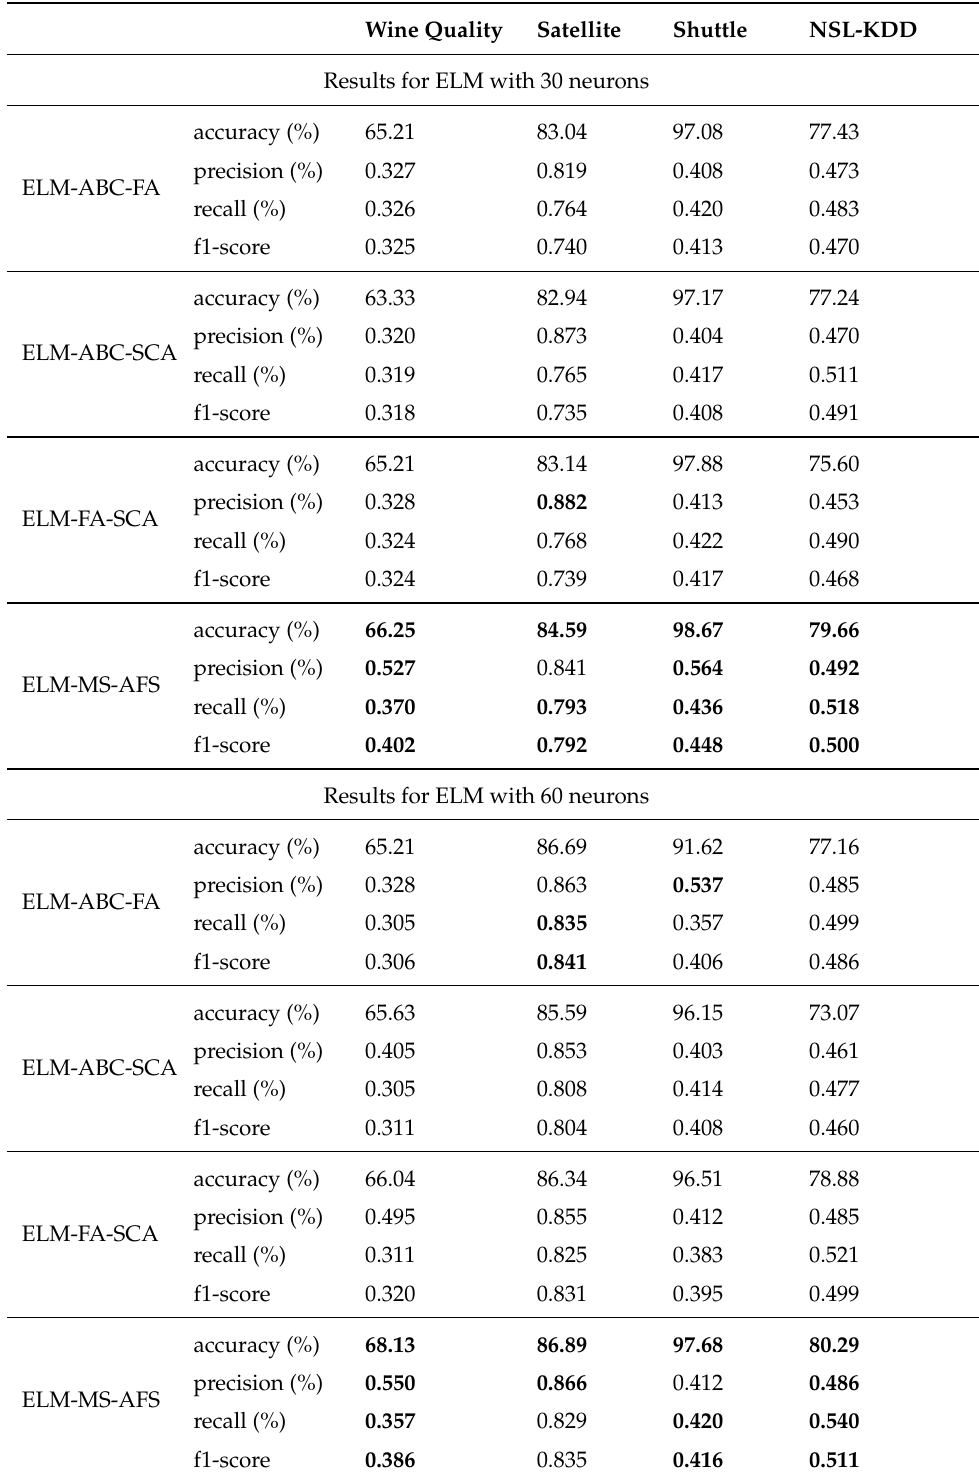
Table 11. Precision, recall, and f1-score comparative analysis—ELM-MS-AFS vs. hybrids. Wine Quality